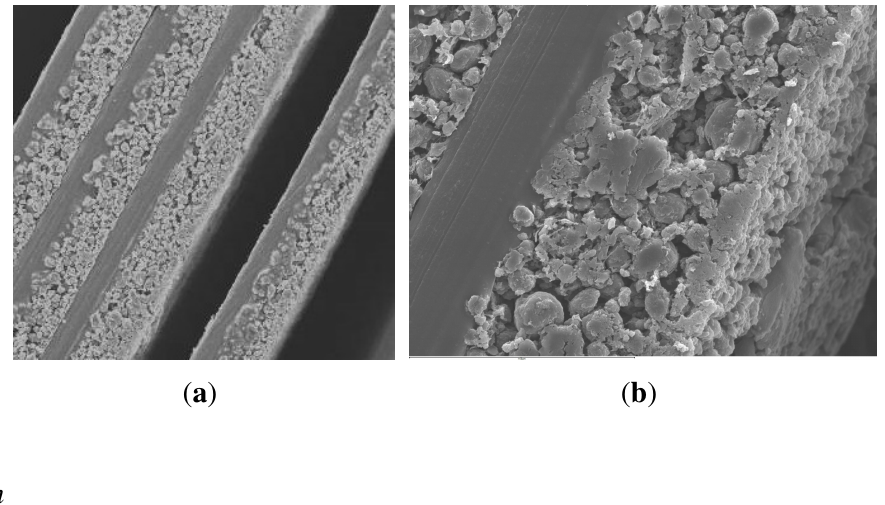
Figure 6. Through-plane SEM images of a prepared anode stack. ( a ) Cutout with four layers; ( b ) cutout of two layers and the